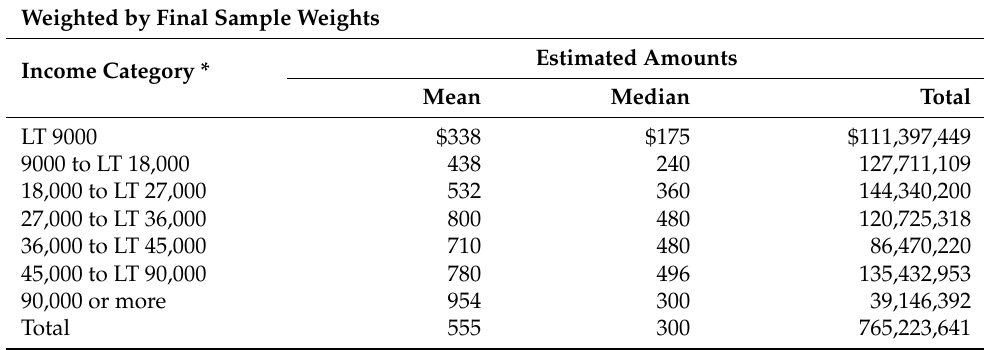
Table 3. Estimated amounts paid during the past year, by income